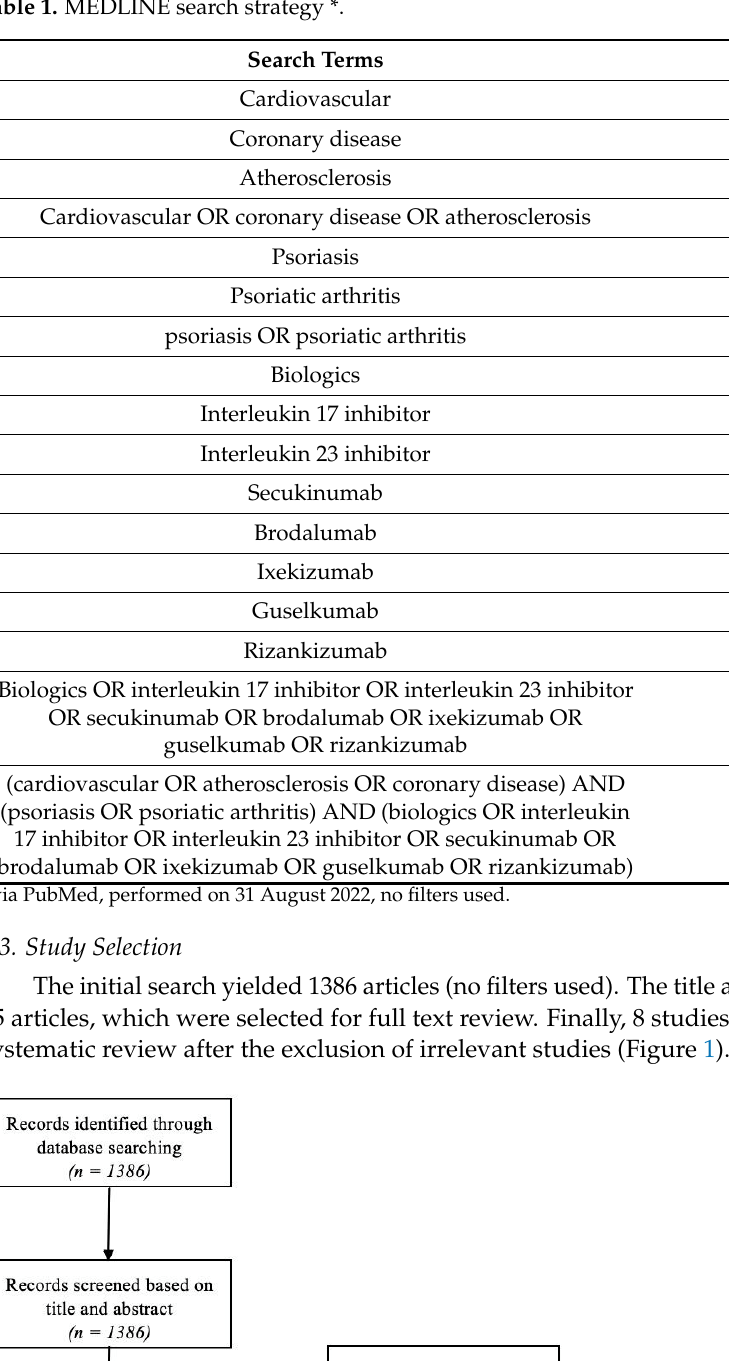
Figure 1. Flow diagram.